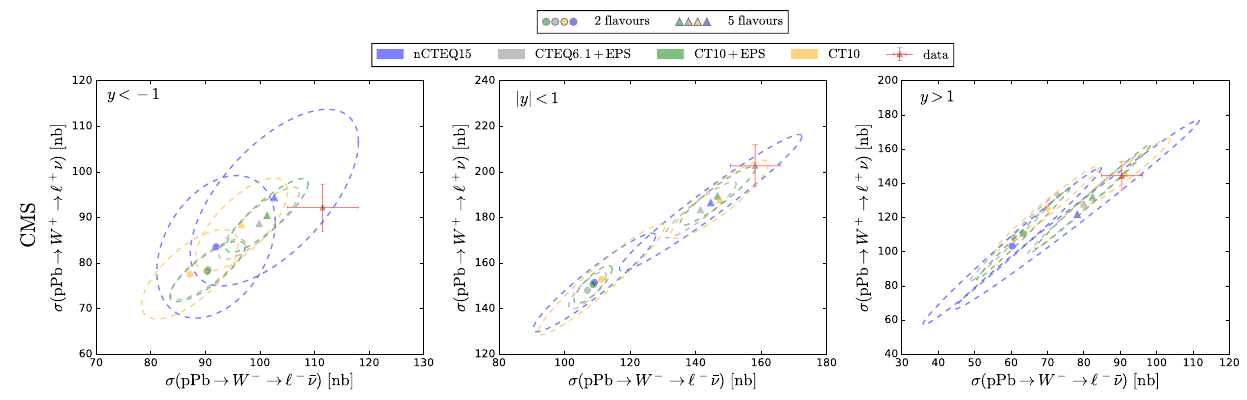
Fig. 14 Same as Fig. 13 but divided into rapidity